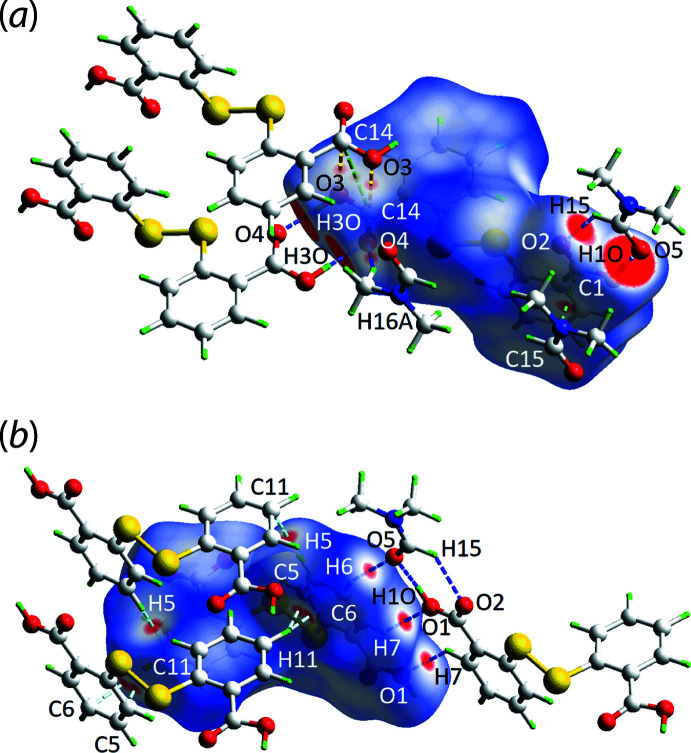
Two views of the d
norm map for the DTBA mol­ecule, showing the relevant short contacts indicated by the red spots on the Hirshfeld surface with varying intensities within the range of −0.0140 to 1.0154 arbitrary units for (a) H3O⋯O4, H1O⋯O5, H15⋯O2, C15⋯C1, C14⋯O3, C14⋯C14 and H16A⋯O4 and (b) H6⋯O5, H7⋯O1, H5⋯C11, H11⋯C5 and H11⋯C6. All H⋯O/O⋯H inter­actions are indicated in blue, H⋯C/C⋯H in light-blue, C⋯O/O⋯C in yellow and C⋯C in green. The close contacts present in the DMF mol­ecule mirror that of the DTBA and hence the relevant d
norm maps are not shown.